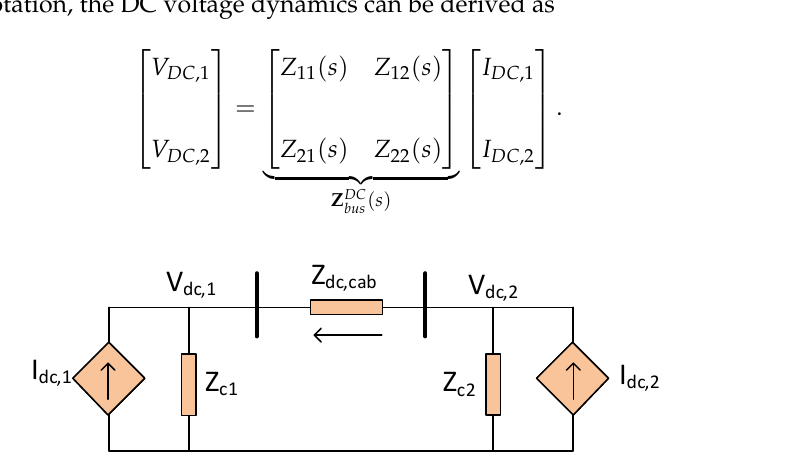
Figure A1. Circuit schematic of the HVDC link based on nodal current